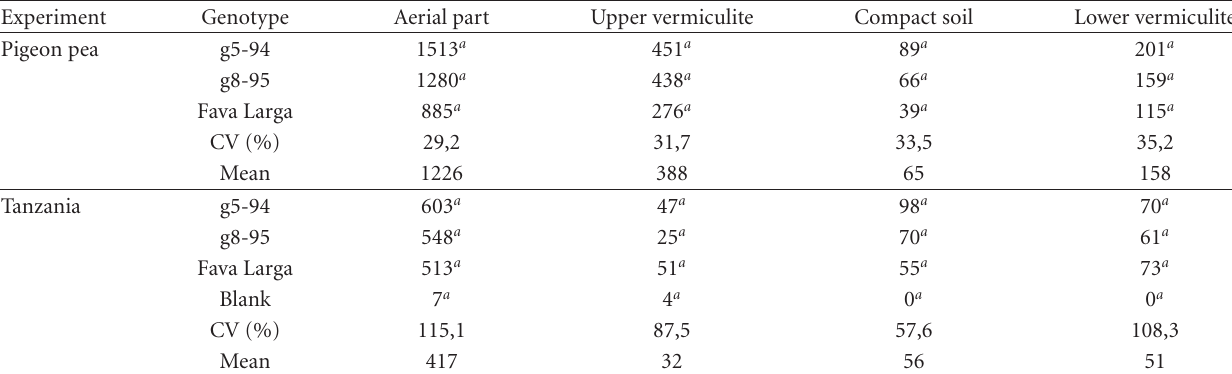
Table 4: Dry matter yields of plant components of three pigeon pea genotypes and of components of Tanzania plants planted after pigeon pea harvest of experiment 8.